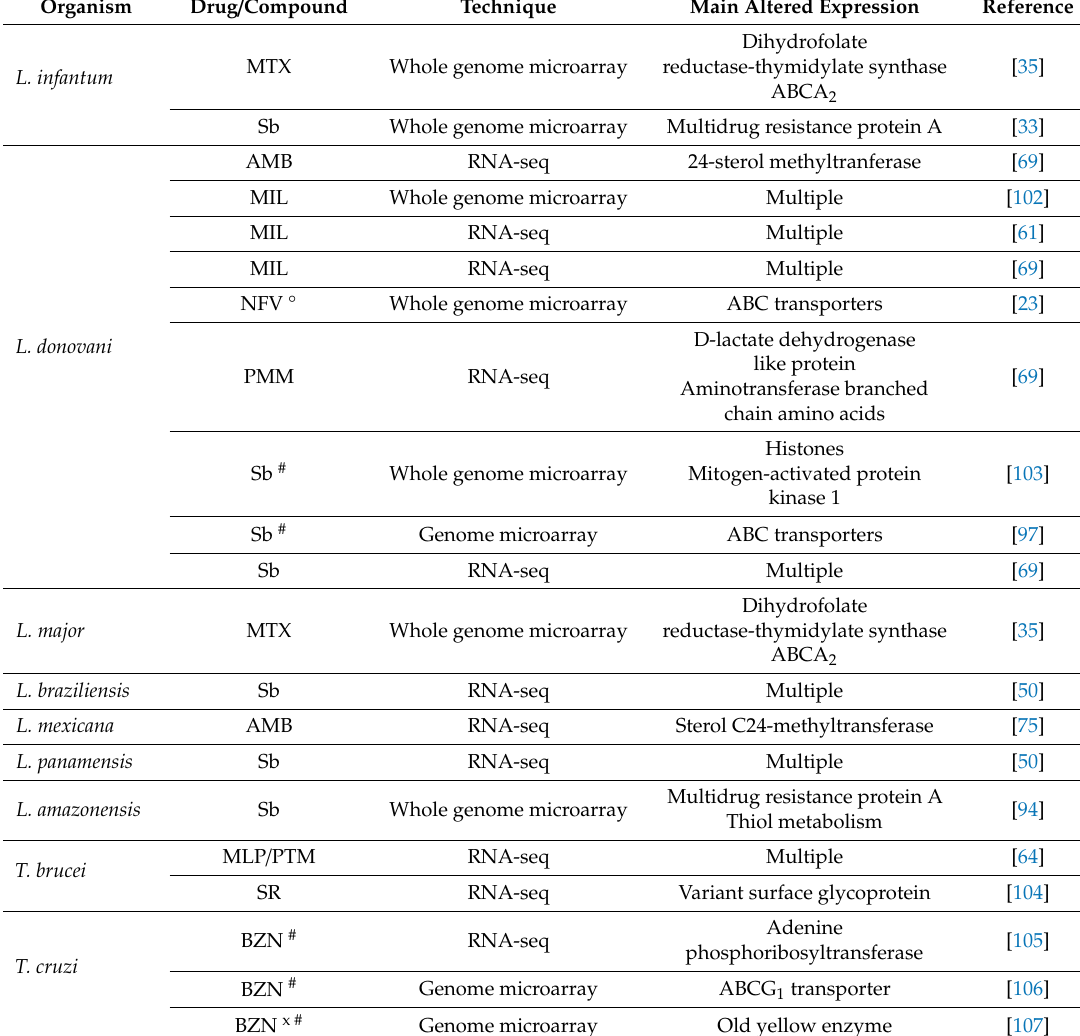
Table 2. Use of untargeted transcriptomics to unravel the MoR of drugs with anti-kinetoplastid e ff ect by comparing resistant and susceptible parasites. Experiments with Leishmania spp. and T. cruzi were performed on promastigotes and epimastigotes,